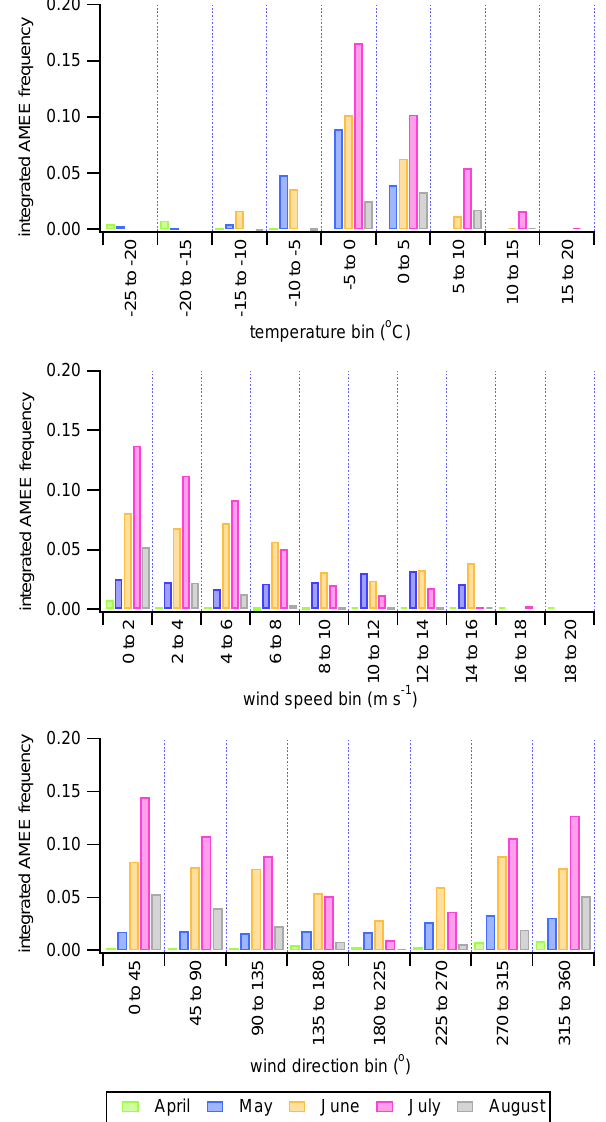
Fig. 4. Integrated atmospheric mercury emission event frequency ( F AMEE ) as a function of temperature, wind speed, wind direction and month for Alert data 1995–2007. Note the change in scale from Figs. 2 and